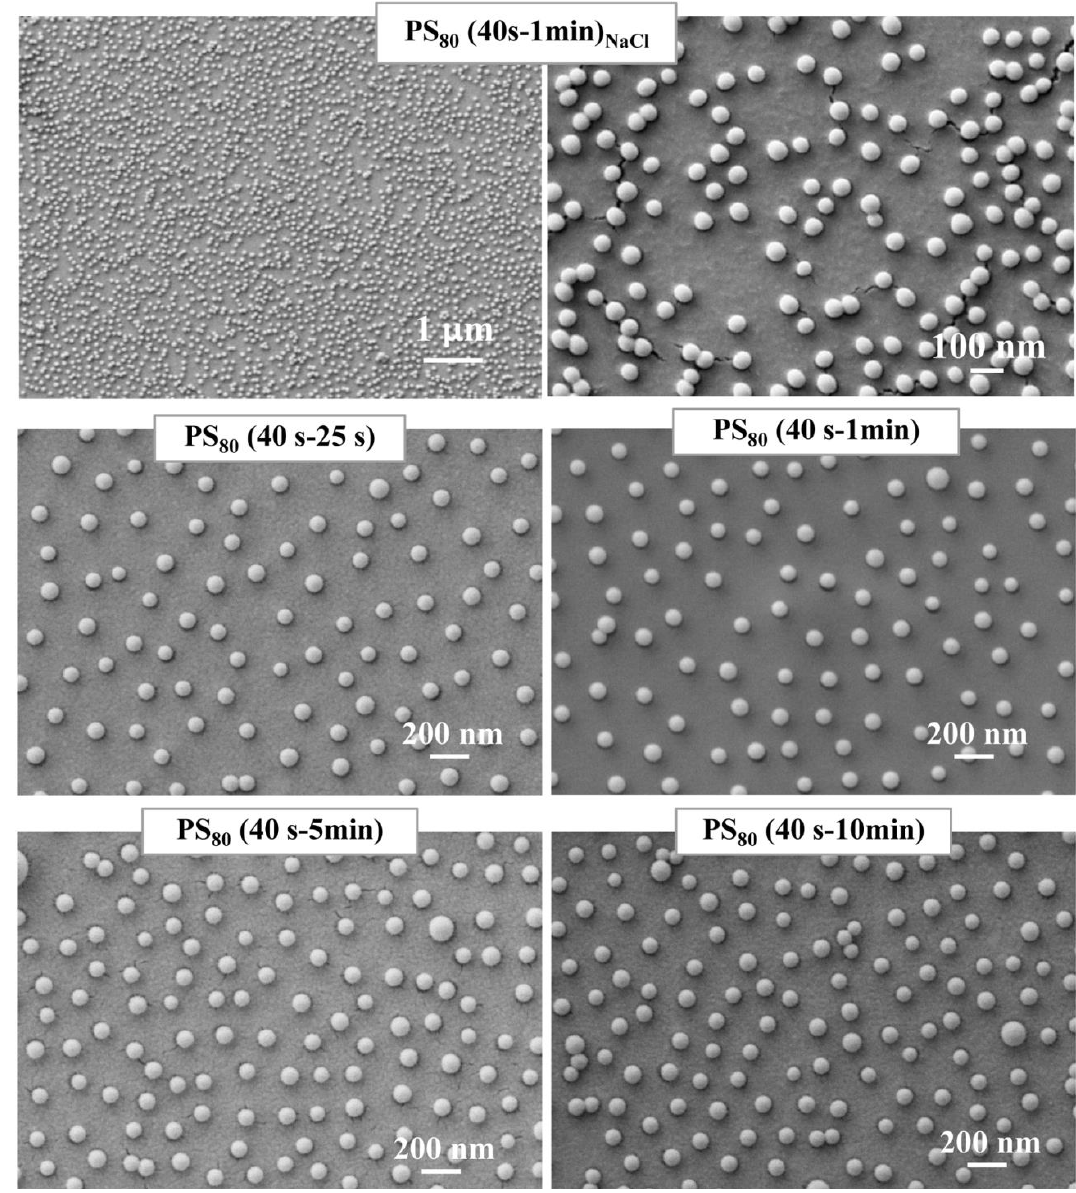
Figure 4. SEM plan view images of colloidal mask consisting of 80 nm diameter polystyrene spheres